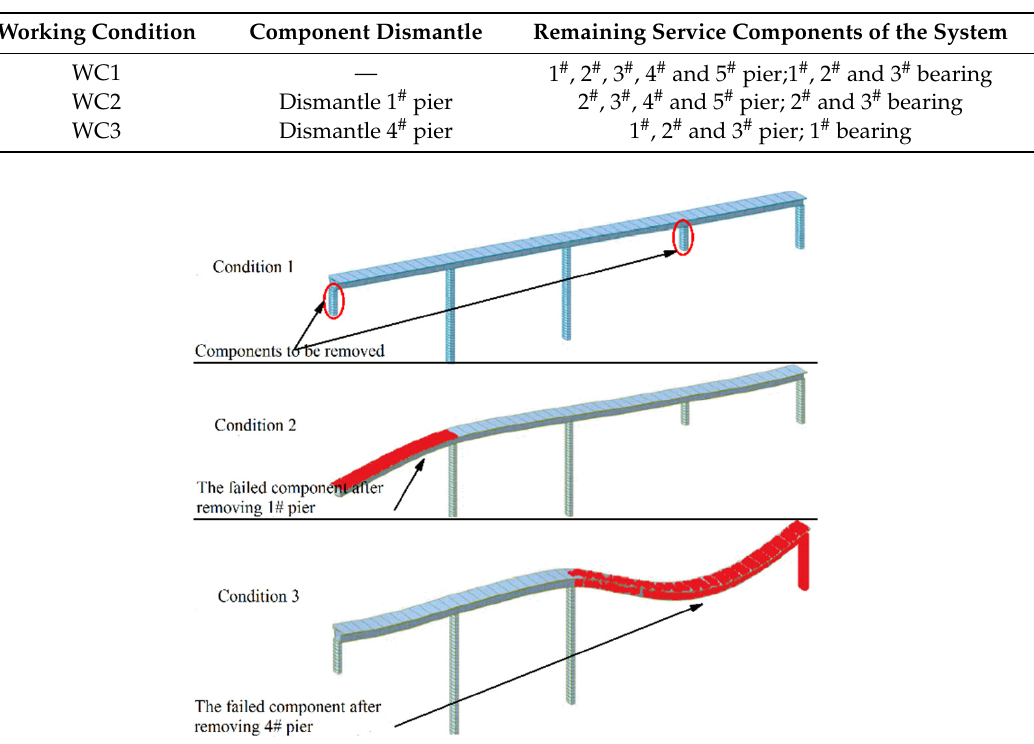
Figure 8. Collapse analysis.